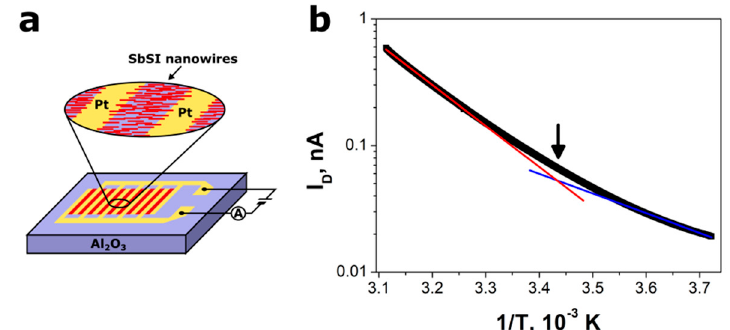
dependence of electric current flowing through SbSI nanowires ( E = 10 6 V/m; p = 10 − 3 Pa, RH = 0%);